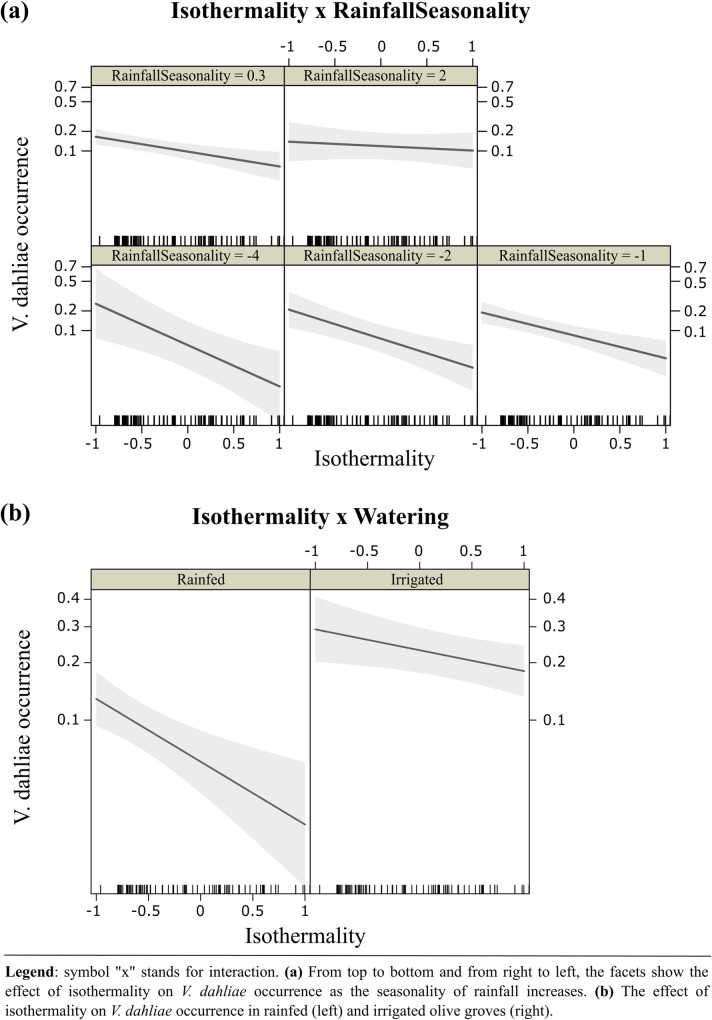
The predicted effect of Isothermality on Verticillium dahliae occurrence as a function of (a) RainfallSeasonality and (b) Watering according to the most plausible model (see Table 1). Effect sizes are shown on a cloglog scale. Shaded areas represent the 95% confidence interval for the fitted cloglog curve.